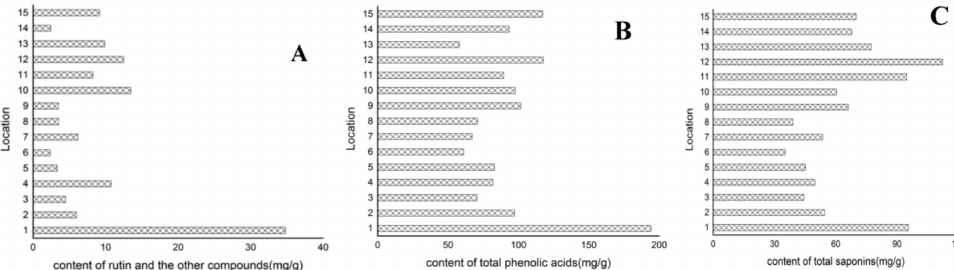
Figure 2. The content of rutin and the other two compounds ( A ); total phenolic acid ( B ) and total saponins ( C ) in 15 batches of Ilex kudingcha C. J. Tseng.